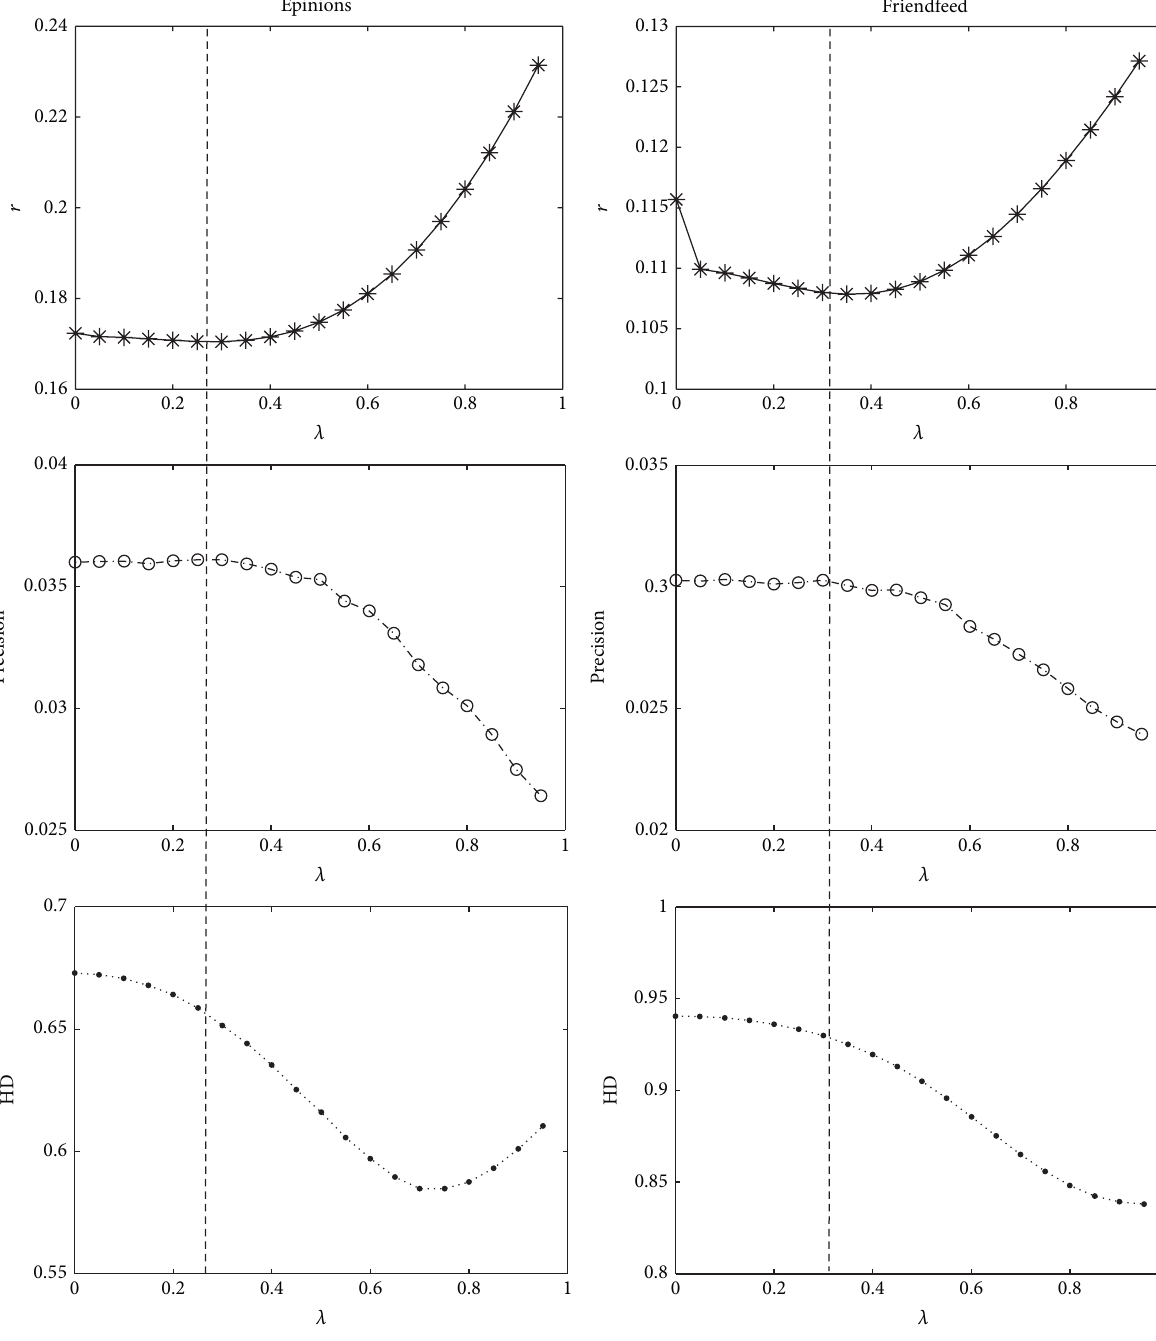
Figure 3: The precision and HD when recommendation list 𝐿 = 20 and 𝑟 in the Epinions and Friendfeed data sets. Each result is obtained by averaging over 10 independent runs, each of which corresponds on a random division of training set and testing